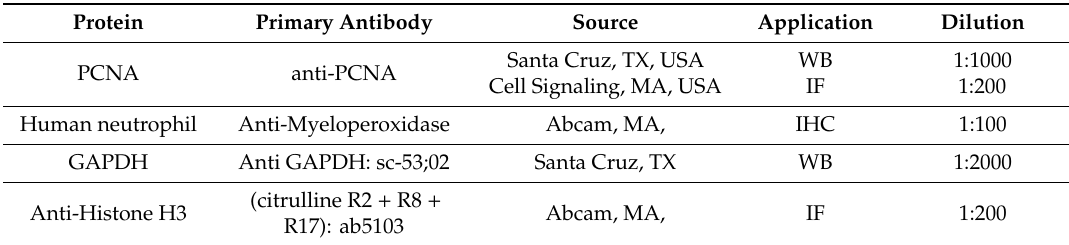
Table 3. Antibodies used in this